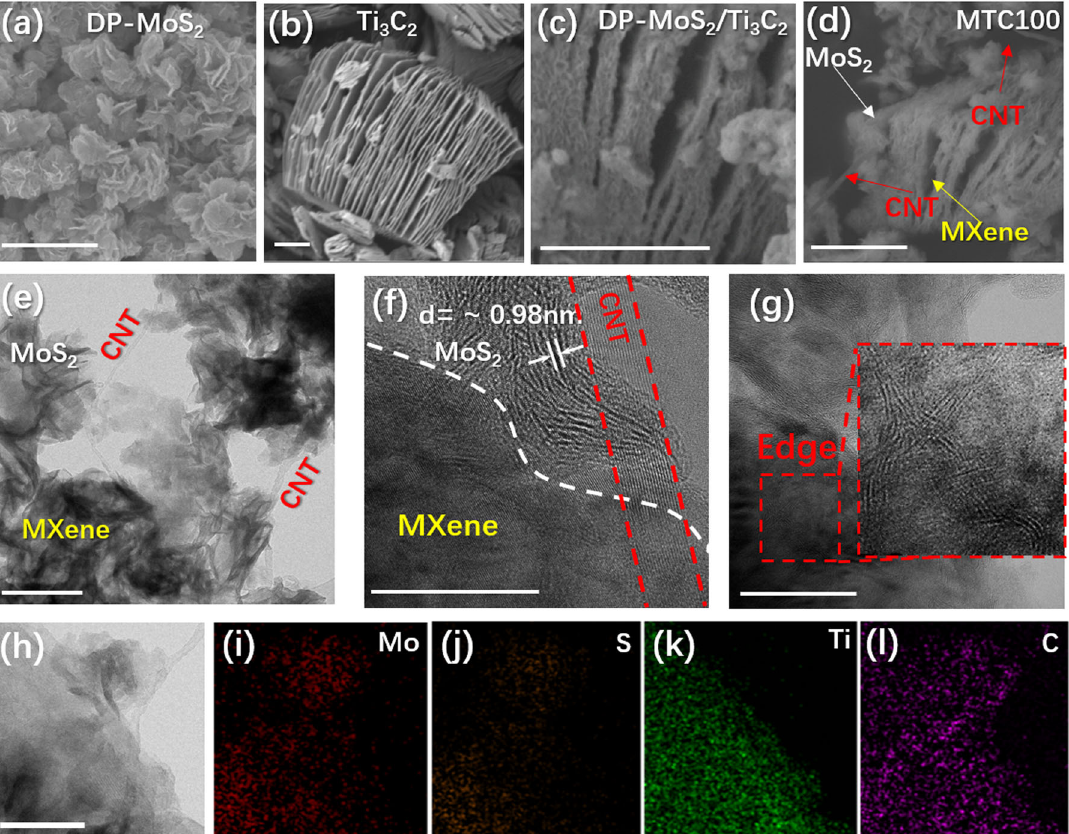
Fig. 2 Morphology characterizations of the ternary structures. a – d are the SEM images of pure 1 T enriched-MoS 2 , Ti 3 C 2 MXene, MoS 2 /Ti 3 C 2 , and MTC100, respectively. The scale bars are 200 nm, 1 μ m, 200 nm, and 200 nm, respectively. e , f are the TEM image and HRTEM image of MTC composite, respectively. The scale bars are 200 nm and 20 nm, respectively. The corresponding EDS elemental mapping is shown in h – l . The scale bar for panel ( h ) is 100 nm. g The HRTEM image of MTC100 and the corresponding enlarged area is displayed to show clear MoS 2 edge structures. The scale bar is 50